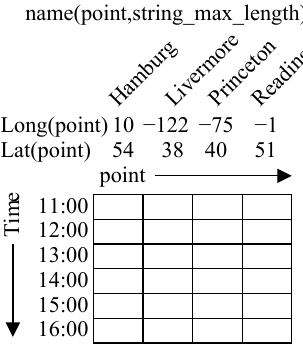
auxiliary coordinate variables must be used to store longitude and latitude values for each location (latitude–longitude lines dashed; grid lines